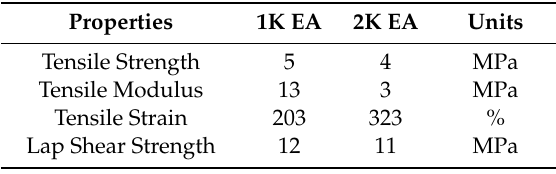
Table 1. Mechanical properties of adhesives used.